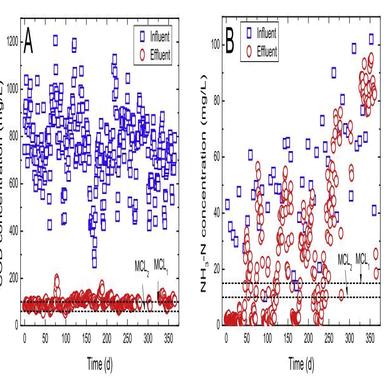
The concentrations of COD (A) and NH3-N (B) in the influent and effluent of an A/O process from Feb. 02, 2016 to Feb. 15, 2017.